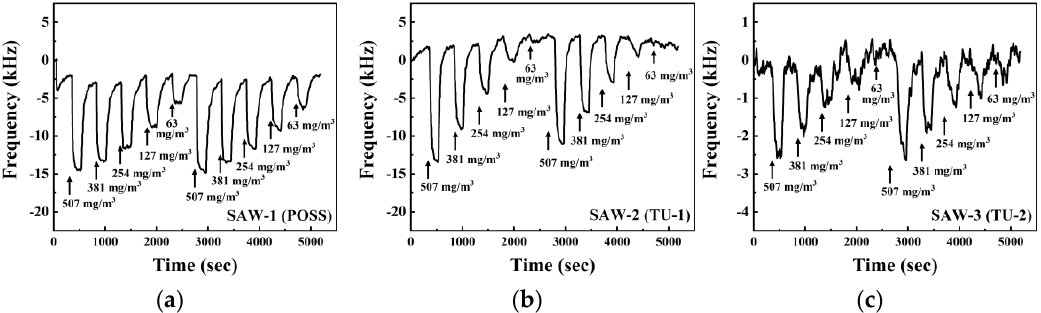
Figure 8. Dynamic response of the SAW sensors coated with different sensing materials: ( a ) POSS; ( b ) TU-1; and ( c ) TU-2 under the exposure to DMMP concentrations ranging from 63 to 507 mg/m 3 . The inserted numbers are the different concentrations of DMMP.